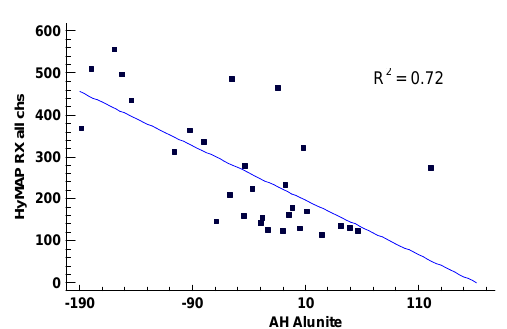
Figure 3. Example of relationship between spectral anomalies RX and Alunite, from HyMAP images.